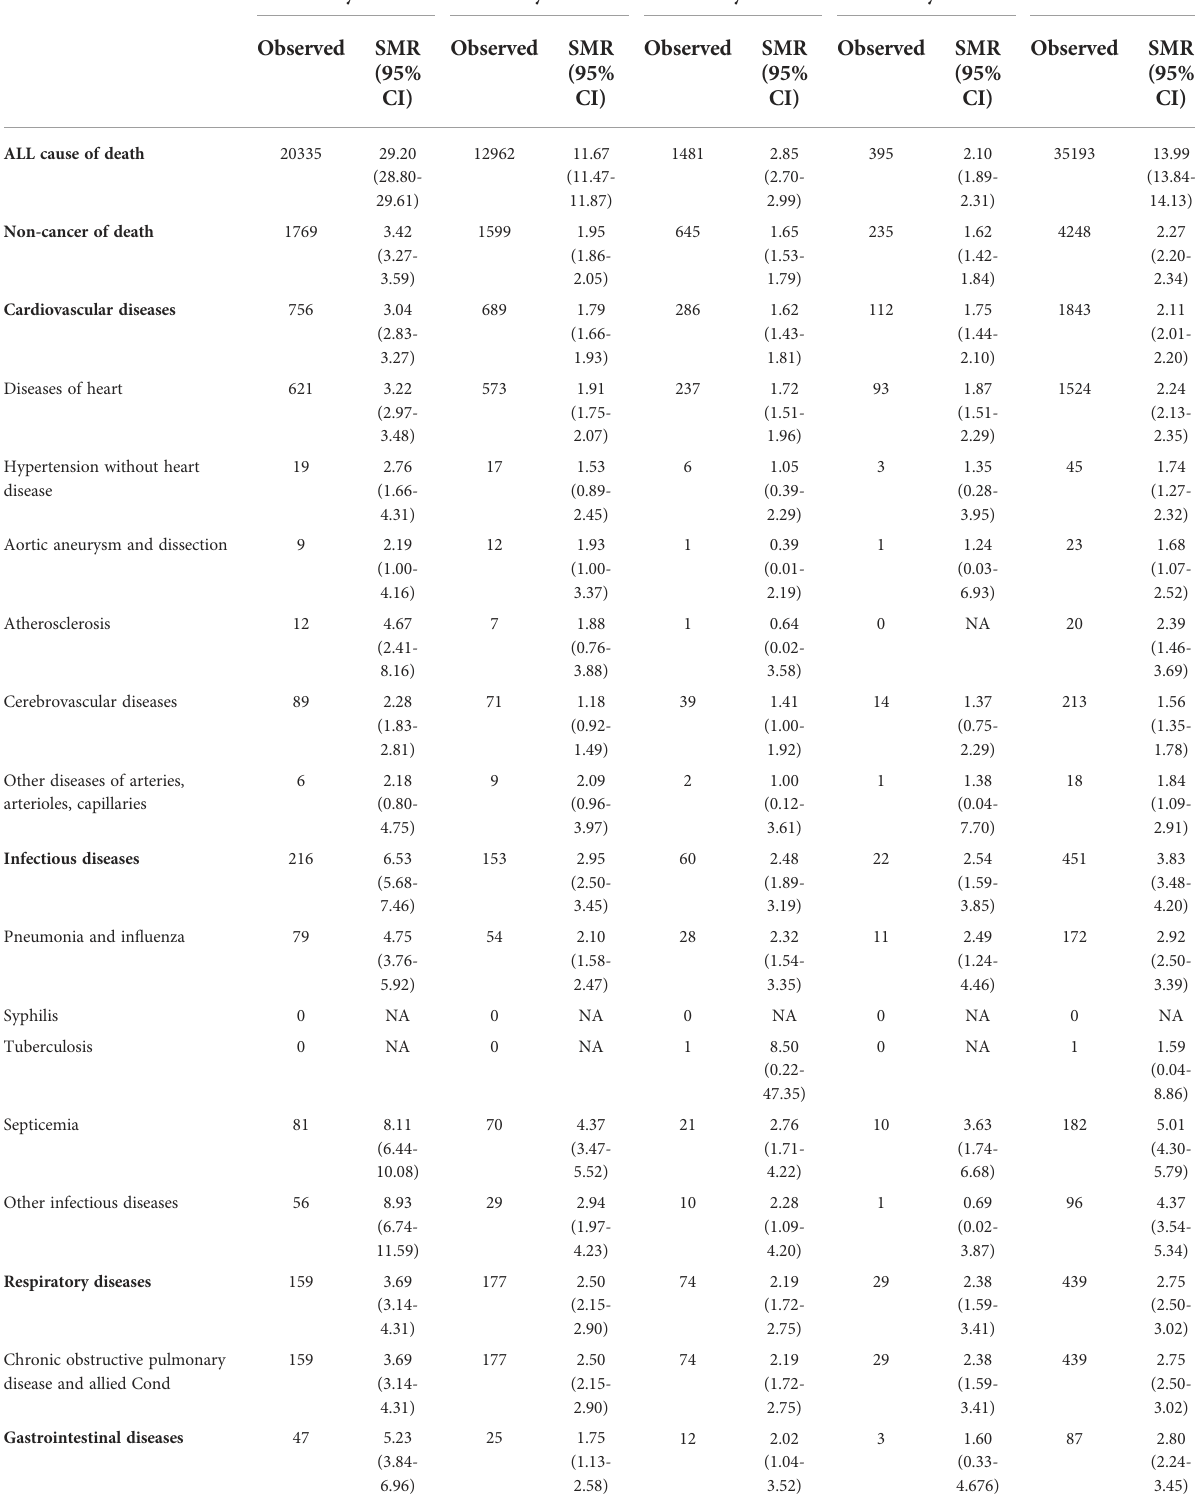
TABLE 2 Standardized-mortality ratios for each cause of death following esophagus cancer diagnosis. Cause of